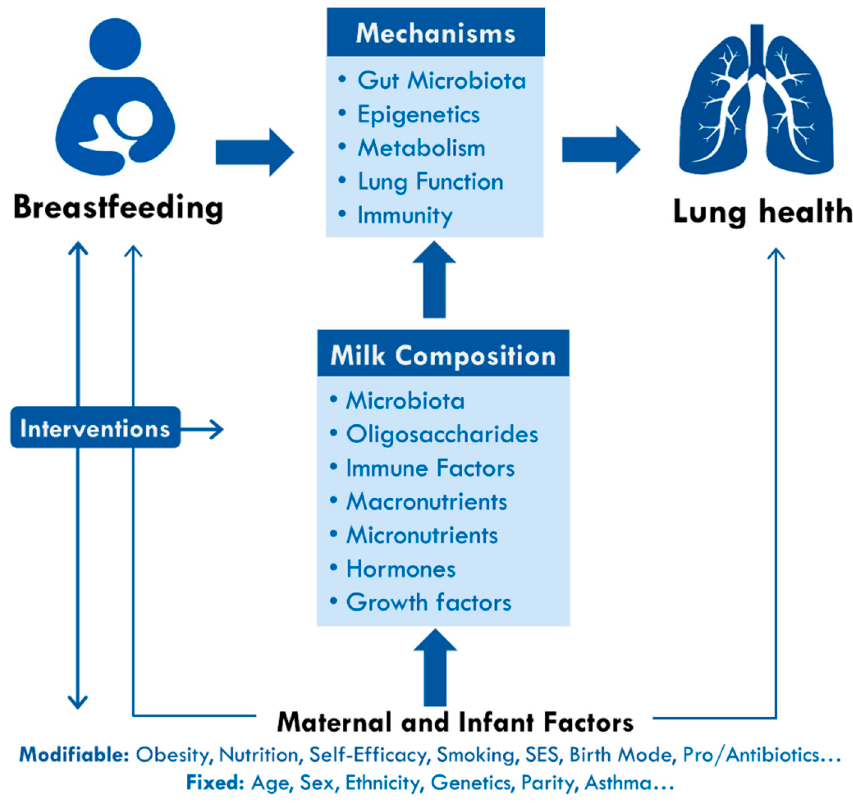
Figure 1. Breastfeeding and the developmental origins of lung health and childhood asthma. Breastfeeding may be associated with lung heath through several potential mechanisms, including modulation of gut microbiota, epigenetics, immunity, and lung development. These processes are driven by multiple bioactive components of human milk, which are influenced by various fixed and modifiable maternal and infant factors. Understanding these mechanisms and associations will help to inform interventions to improve lung health and reduce asthma risk by supporting breastfeeding and optimizing milk composition and infant nutrition. SES, socioeconomic status.